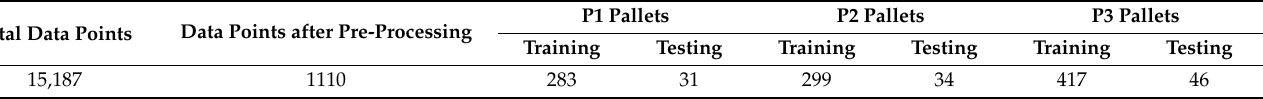
Table 2. The datasets used in model training and